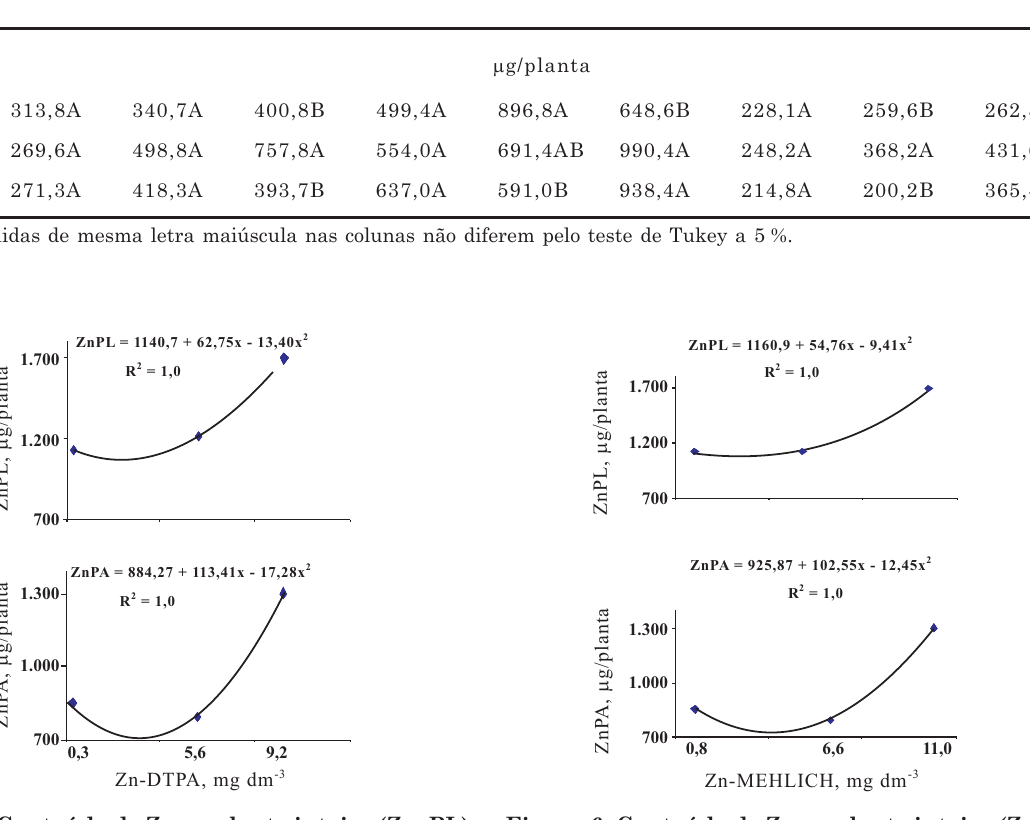
Figura 6. Conteúdo de Zn na planta inteira (Zn–PL) ou na parte aérea (Zn–PA) em função do teor disponível no solo pelo extrator Mehlich-1, nas plantas enxertadas (MN/AP).